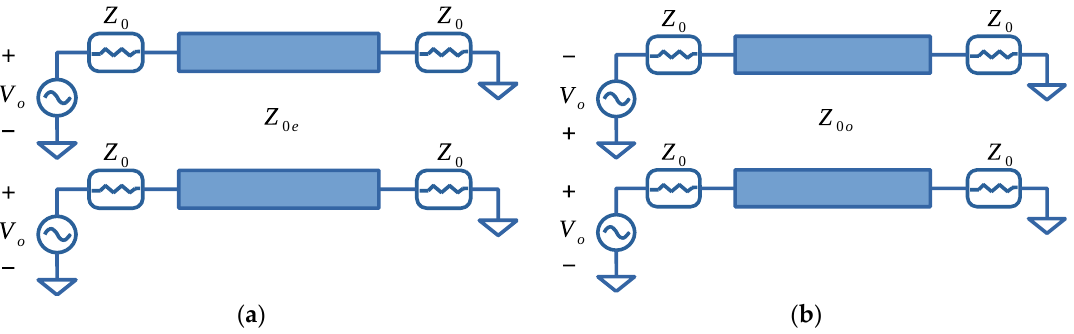
Figure 1. Parallel coupled-line coupler operation: ( a ) even-mode operation; ( b ) odd-mode opera-